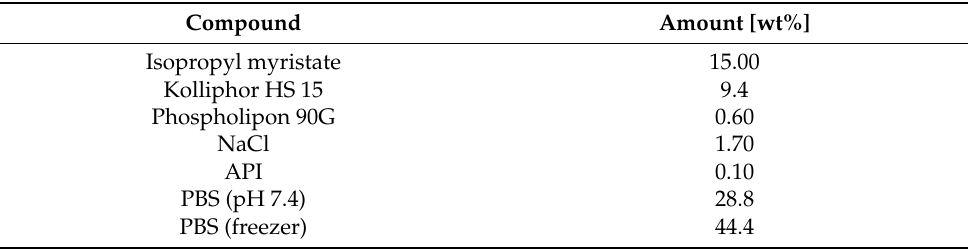
Table 2. The composition of lipid nanocapsules prepared in this work for topical delivery of hydro- cortisone (HC) and hydrocortisone-butyrate (HCB).